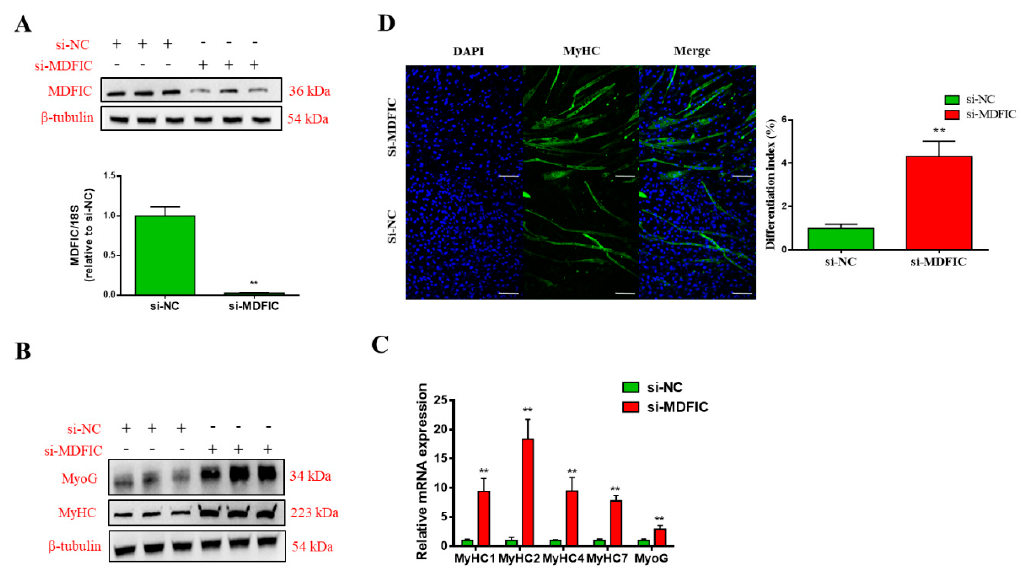
Figure 5. Knockdown of MDFIC promotes the MD of PDGFR α − bPCs. ( A ) The mRNA and protein expression level of MDFIC in PDGFR α − bPCs transfected with si-MDFIC or si-NC. β -tubulin was used as the reference gene. The protein ( B ) and mRNA ( C ) expression levels of MyoG and MHC in PDGFR α − bPCs transfected with si-MDFIC or si-NC at D5 after MD. β -tubulin was used as the reference gene. ( D ) MyHC positive cells (green) at D5 of MD after si-MDFIC or si-NC transfection. Scale bar represents 100 µ m. Di ff erentiation index of myoblast after induction for D5. Results are representative of the mean ( ± SD) of three independent analyses. ** p < 0.01. Genes 2020 , 11 , x FOR PEER REVIEW